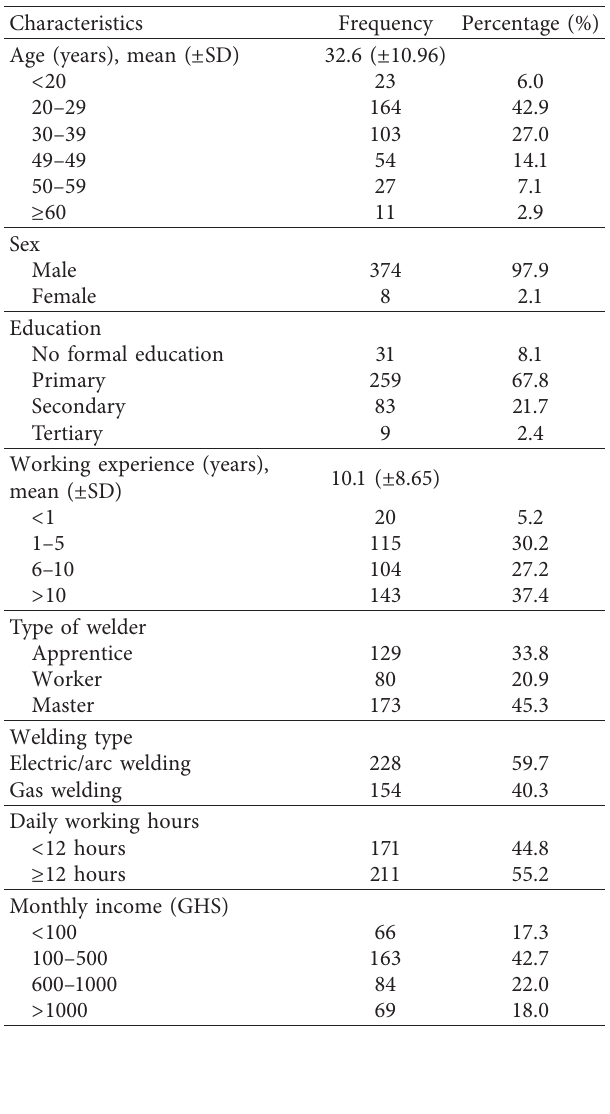
Table 1: Background characteristics of welders ( N � 382 ).